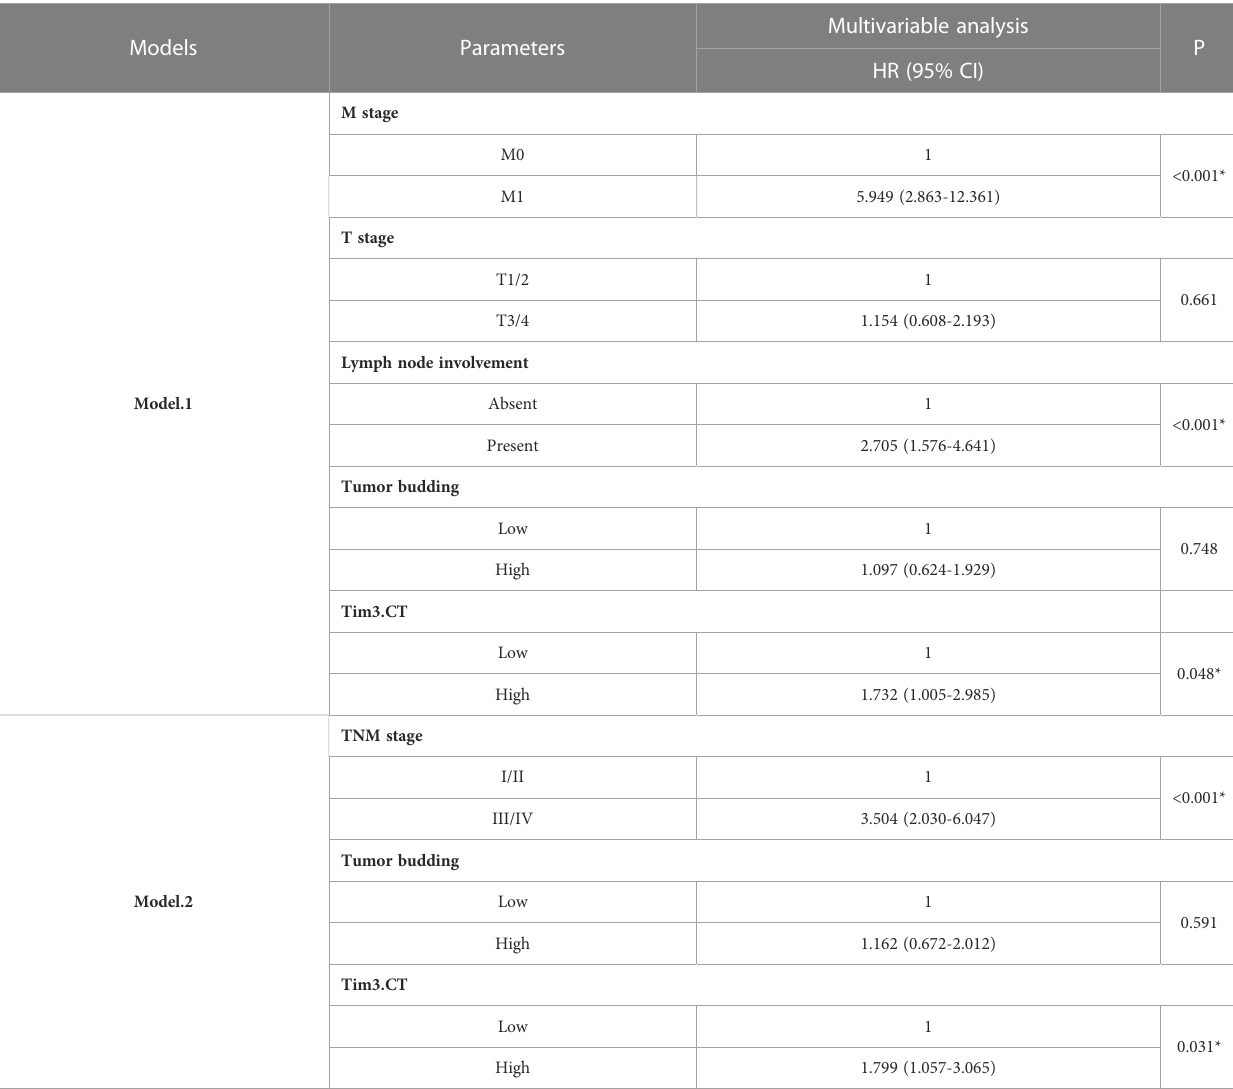
TABLE 6 Multivariable Cox regression survival